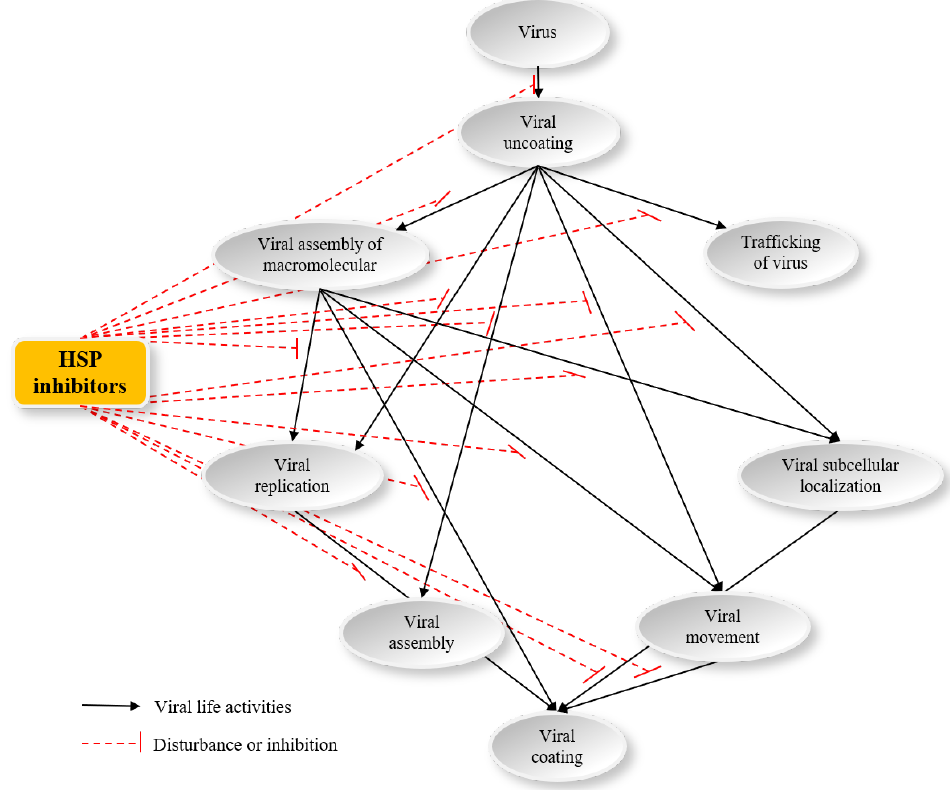
Figure 8. The antiviral mechanism of HSP inhibitors. Abbreviations: HSP, heat shock protein.